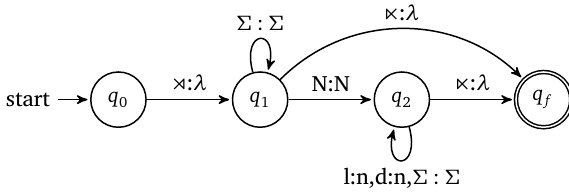
Sequential 1-way FST for Kikongo nasal harmony